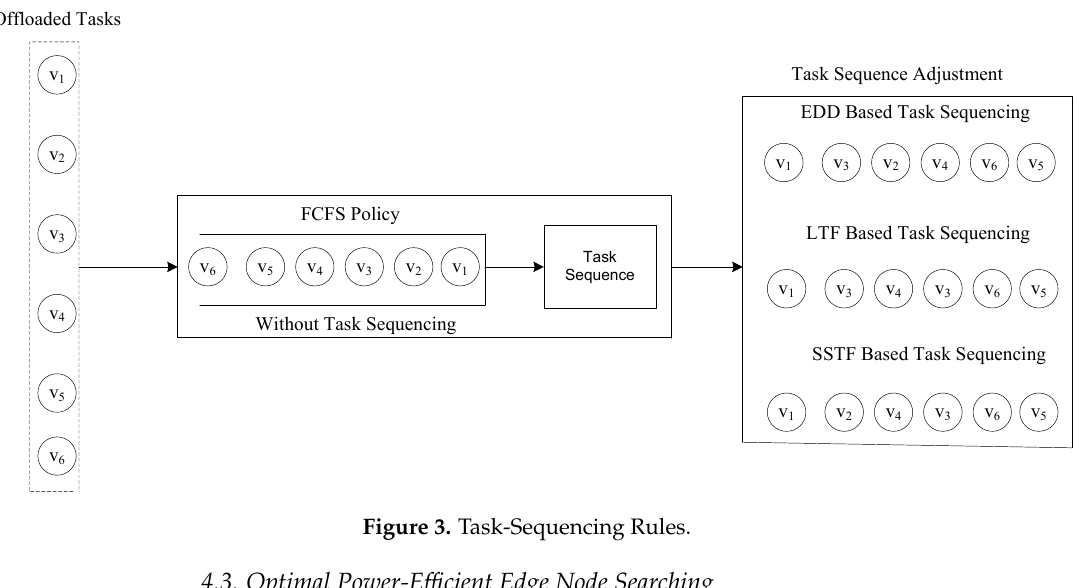
Figure 3. Task-Sequencing Rules.